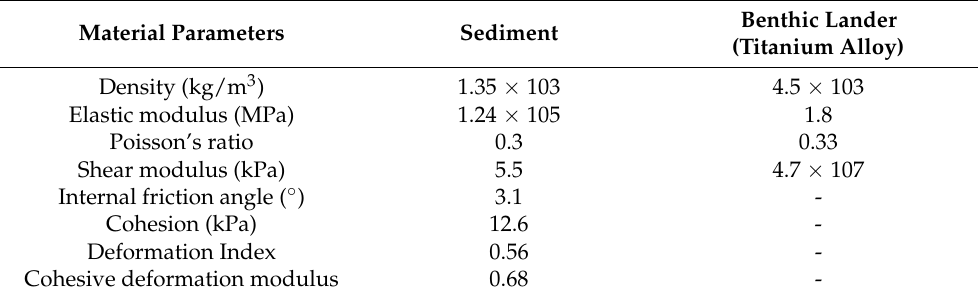
Figure 6. Simplified bottom collision model. Table 1. Material parameters.